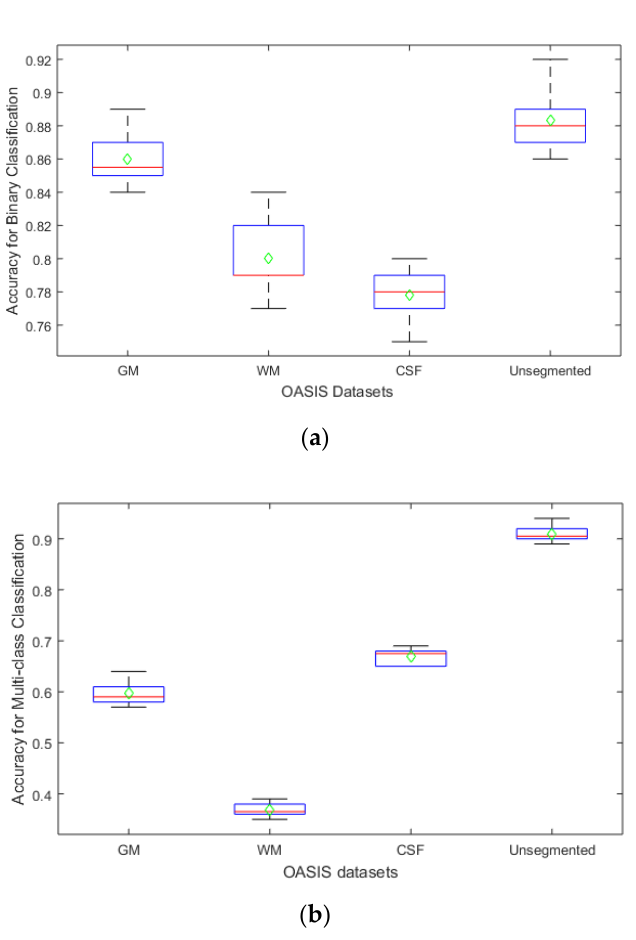
Figure 11. Boxplot of the results on OASIS dataset under proposed segmentation—GM, WM, CSF, and Un-segmented, in terms of accuracy. The arithmetic mean is presented in green and the median in red ( a ) represents the results for binary dataset. ( b ) Classification results of multiple classes. Table 2. Results of transfer learning for di ff erent numbers of